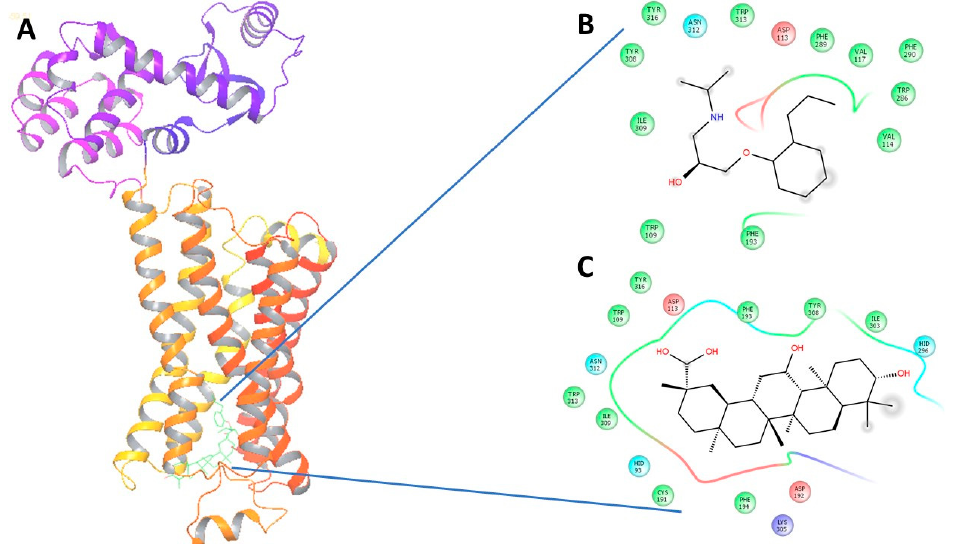
Figure 5. ( A ) The 3-dimensional image of β 2-AR docked with GA and alperenolol signifying same binding region for both drug molecules; ( B ) 2-Dimensional image of the interacting amino acid residues with alperenolol; ( C ) 2-Dimensional image of the interacting amino acid residues with GA molecule.